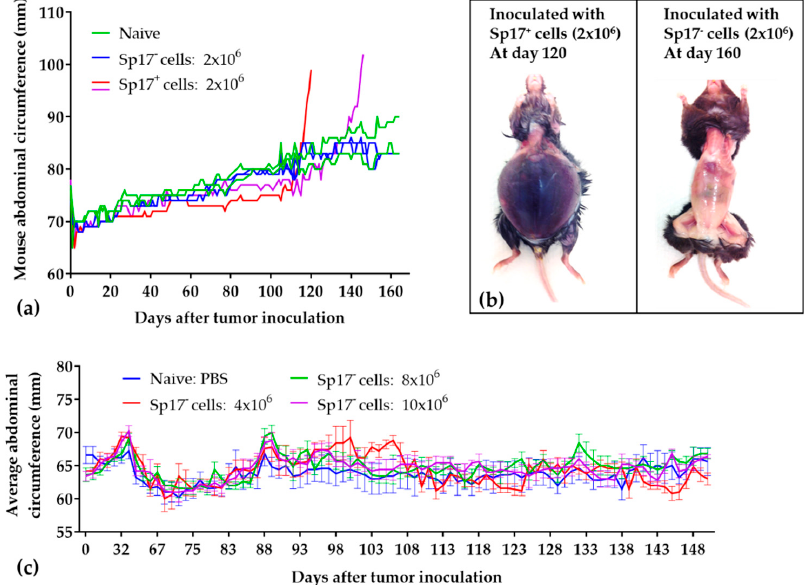
Figure 2. Tumorigenicity of Sp17 + and Sp17 − ID8 cells in vivo. ( a ) Direct comparison of tumorigenicity of the Sp17 + and Sp17 − ID8 cell clones. Female C57BL/6 mice ( n = 2/group) were injected intraperitoneally with 2 × 10 6 of Sp17 − ID8 cells (blue) or Sp17 + ID8 cells (red and purple). Negative control mice received 100 µL PBS (green). Tumor growth were determined by the changes of the mouse abdominal circumferences (mm) over a period of time. Data is shown as the daily abdominal circumference (mm) for each individual mouse measured from day 1 to the study endpoint; ( b ) Representative images of mice at cull which had received either Sp17 + or Sp17 − ID8 cells, confirming the presence/absence of tumor mass; ( c ) Additional number of Sp17 − ID8 cells (4 × 10 6 , 8 × 10 6 , and 10 × 10 6 per mouse) were inoculated to female C57BL/6 mice ( n = 5/group) intraperitoneally, but failed to induce tumors (monitored up to 150 days post inoculation). Data presented as average of mouse abdominal circumference (mm) ± SEM measured at each time point. Negative control mice received 100 µ L